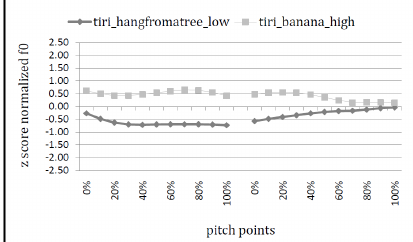
Figure 14: Normalized pitch contours for [tiri], (n=20{5 speakers*4 iterations each})